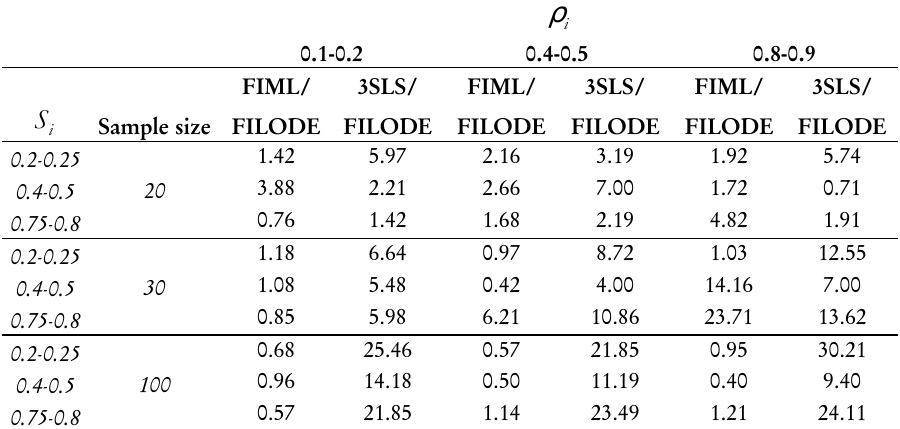
r i and sample size - Normal error